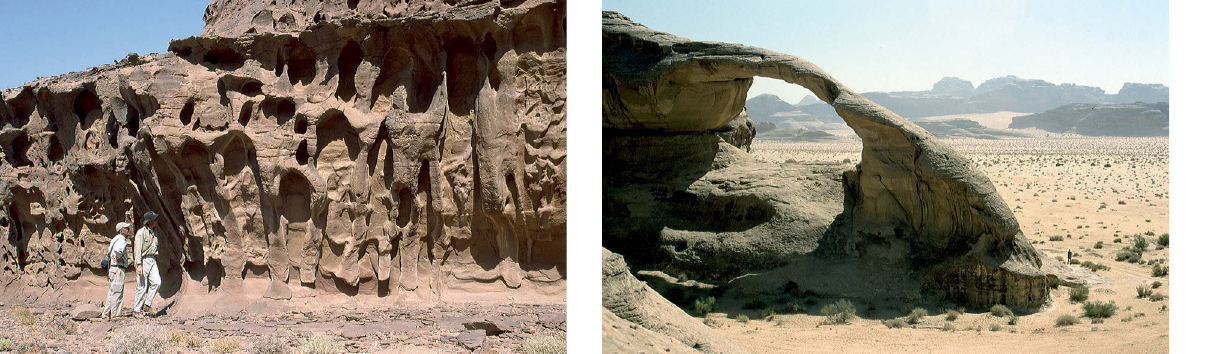
Fig. 2b. Example of sandstone rock slopes in south-west Fig. 2d. Example of sandstone rock slopes in south-west Jordan: extensive cavernous weathering within the Umm Jordan: one of the rock arches in the Jebel Al Kharaz massif ‘Ishrin sandstone built of the Disi